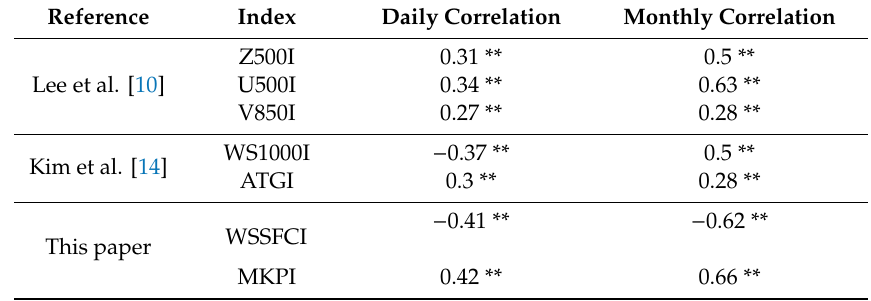
Table 2. Pearson’s correlation coe ffi cient between particulate matter ( < 10 µ m) and 7 indices during the winters of the 2001–2014 period. ‘**’ indicates that the two-tailed p -value of the Pearson correlation is less than